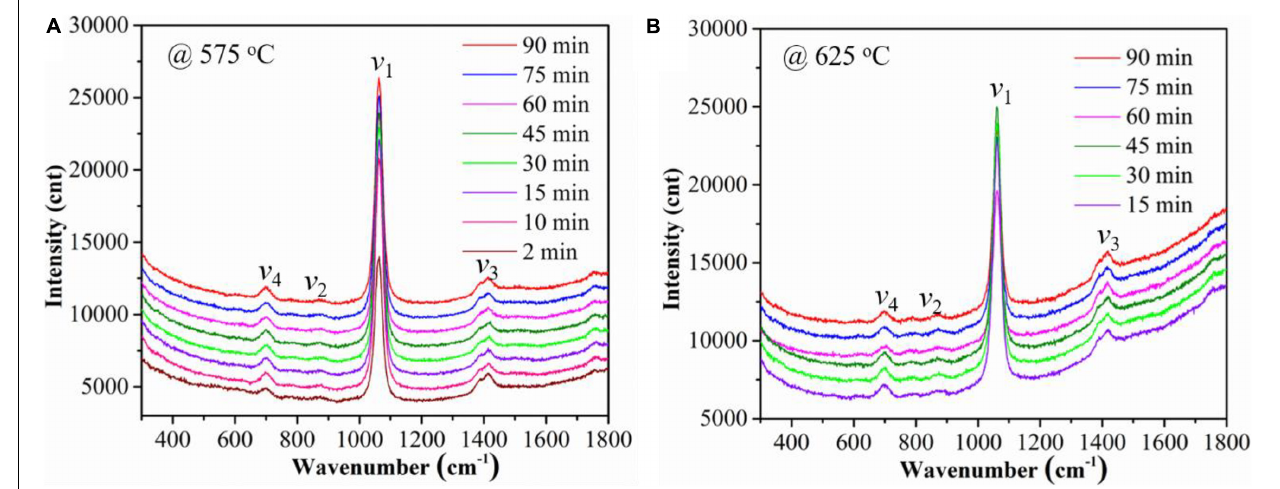
FIGURE 2 | The effects of temperature and time on Raman spectra of the Ag-MC sample in dry 10% CO 2 gas (gas #3). (A) 575 ◦ C and (B) 625 ◦ C.